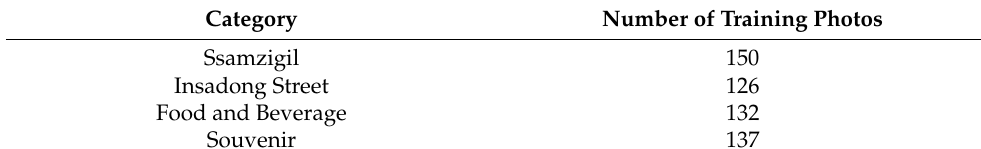
Table 4. Number of training photos by category in Insadong.